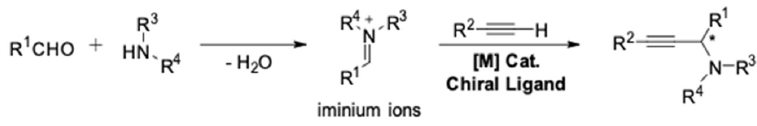
Figure 12. Asymmetric A 3 -couplings with secondary amines.